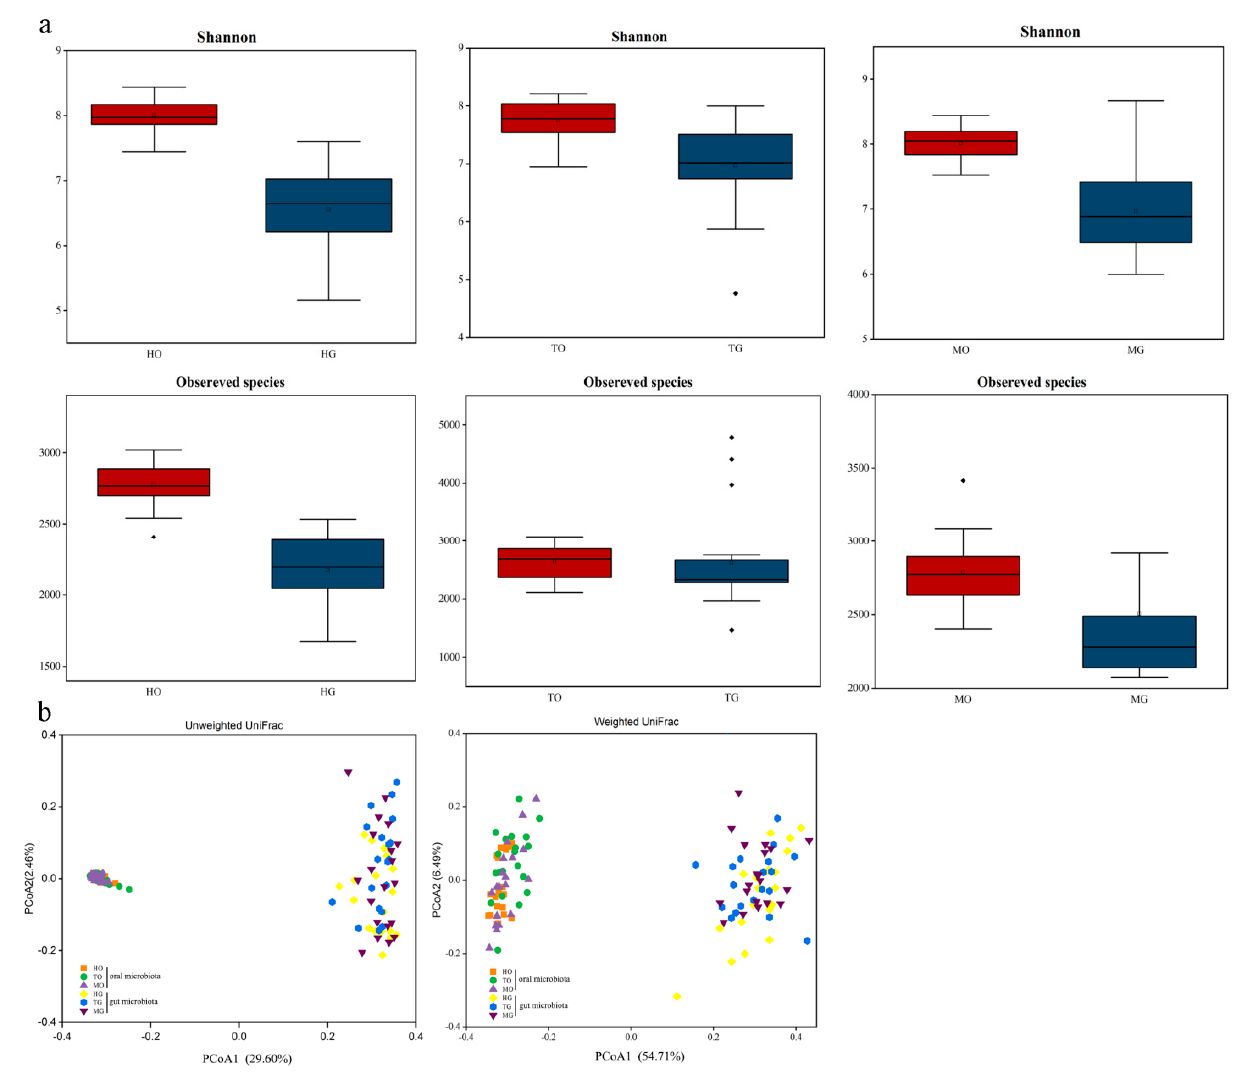
Figure 4. ( a ) Alpha diversity indices of the oral and gut microbiota across ethnicities. HO, oral of the Han population; HG, gut of the Han population; TO, oral of the Tibetan population; TG, gut of the Tibetan population; MO, oral of the Hui population; MG, gut of the Hui population. Different lower-case letters indicate significant differences between the groups. ( b ) PCoA based on unweighted and weighted UniFrac distances comparing the bacterial community between the oral and gut microbiota.